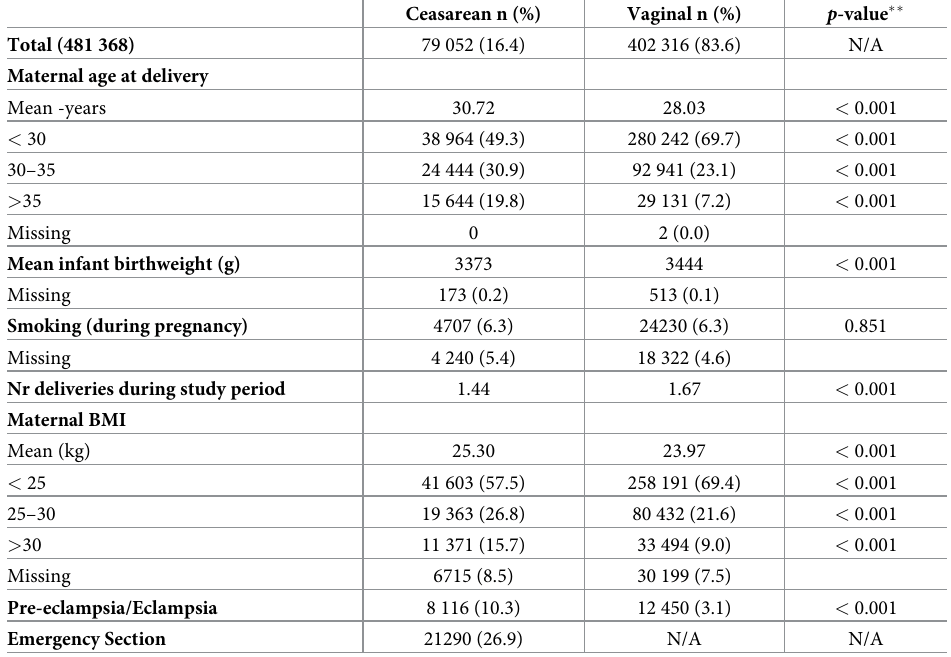
Table 1. Maternal characteristics �